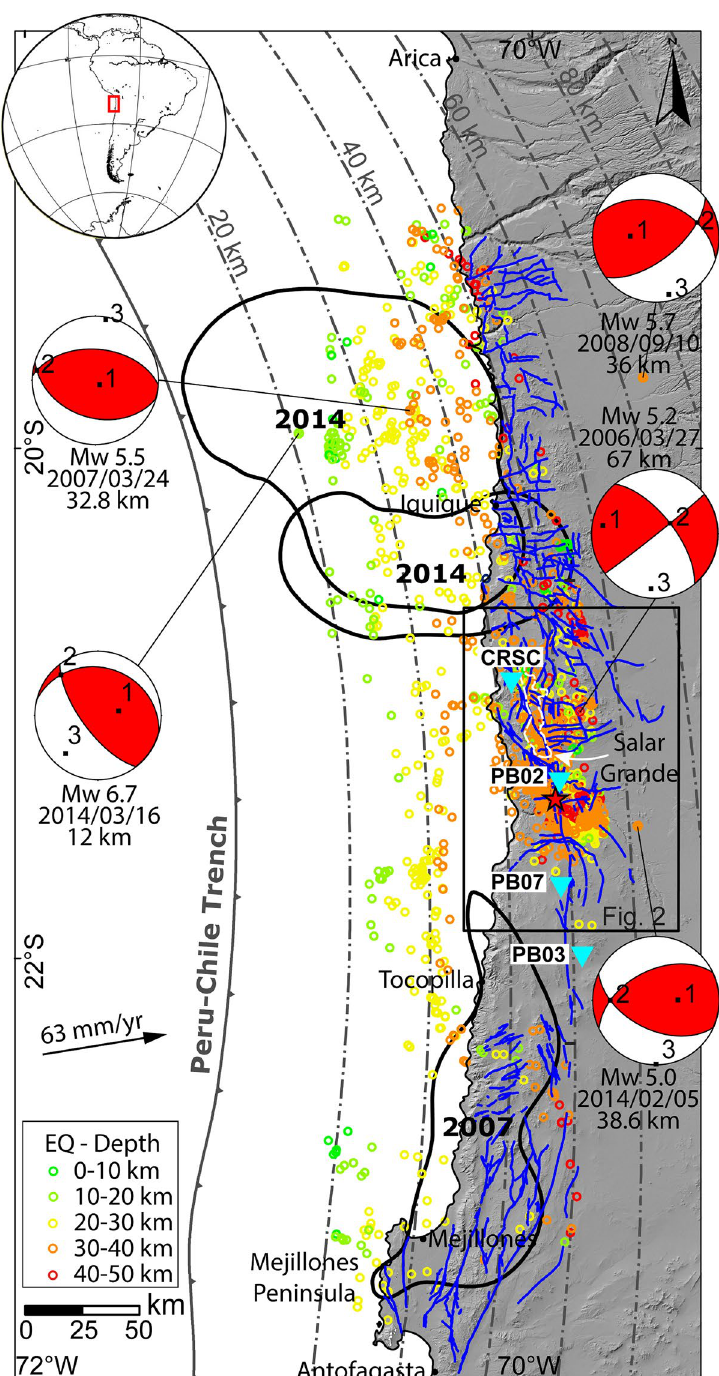
Figure 1. Location of the study area (inset upper corner left side) and upper plate faults in northern Chile; the epicentre of the main M w 6.3 earthquake is indicated by a red star, relocation using SEISAN, (https:// www. geo. uib. no/ seismo/ SOFTW ARE/ SEISAN/). Focal mechanisms provided for the CMT catalogue of M w > 5.5 upper plate earthquakes that occurred from 1995 to the present. The numbers represent 1 = tensional axes, 2 = intermedia axes, and 3 = compressional axis calculated with the software FaultKin (http:// www. geo. corne ll. edu/ geolo gy/ facul ty/ RWA/ progr ams/ fault kin. html). The black contours represent > 0.5 m coseismic slip for the M w 8.2 Iquique earthquake (2014) and the M w 7.7 major aftershock of Iquique 40 , and M w 7.7 Tocopilla earthquake. Dashed grey lines show the depth of the interplate contact from Slab 2.0 41 . Circles with a colour scale show the hypocentre location of the upper plate earthquakes 7 , aftershocks of the M w 8.1 Iquique earthquake were filtered. Convergence velocity calculated according to Chlieh et al. 42 . Hillshade map of northern Chile (grey background map) was generated in ArcGIS version 10.8.2 (https:// www. esri. cl/ es- cl/ inicio) based on the Global SRTM (Shuttle Radar Topography Mission of NASA) 1 Arc-Second DEM (https:// earth explo rer. usgs.